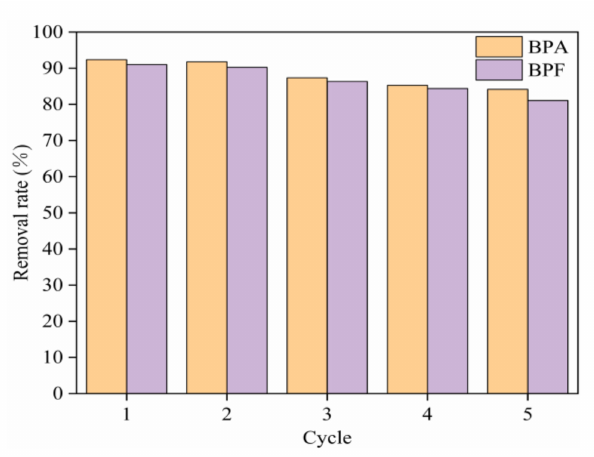
Figure 8. Recyclability cycles performed for MCGC.